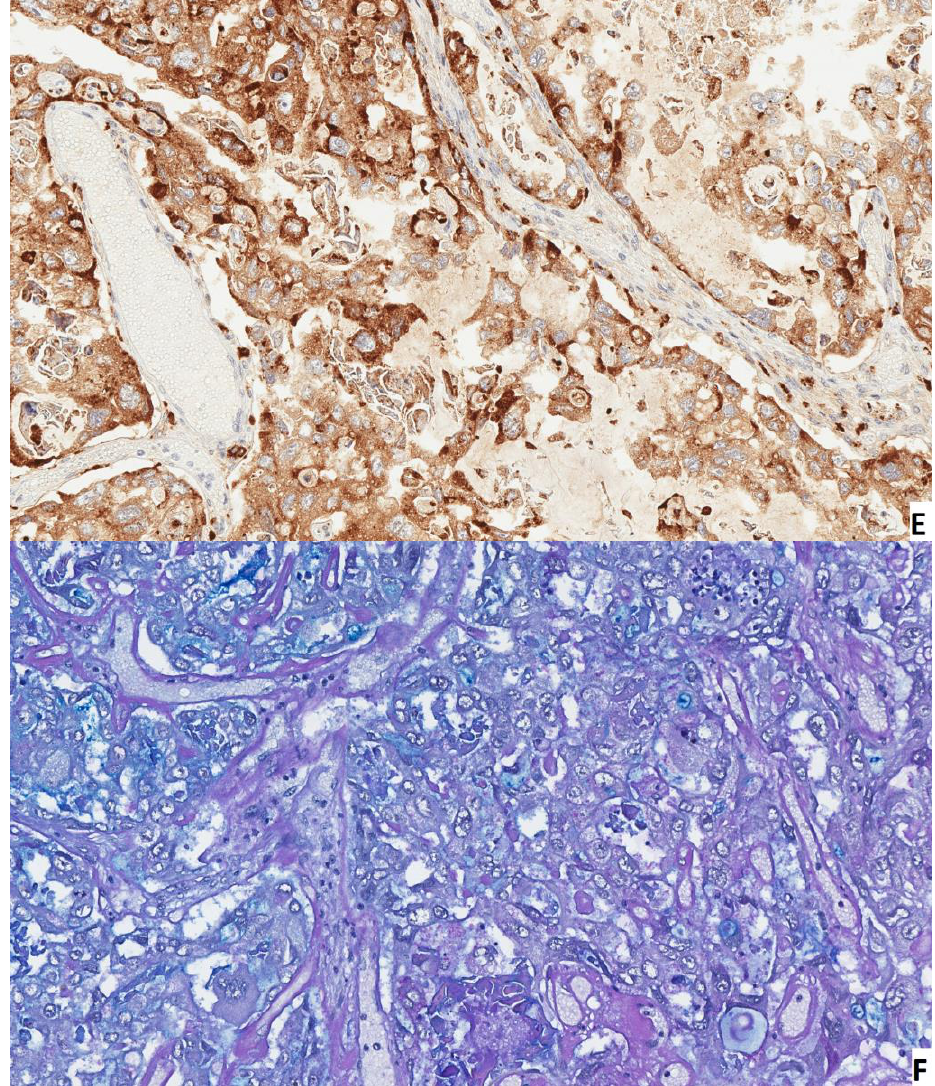
Figure 3. Histopathology of clear cell carcinoma. H&E staining ( A ) shows variation between cells with clear and light eosinophilic cytoplasm. Immunohistochemistry immunoprofile is Wilms tumor 1 (WT-1) negative ( B ), p-53 positive ( C ), HNF1beta negative ( D ), Napsin-A positive ( E ) tumor. Alcian blue/periodic acid–Schiff (AB/PAS) staining ( F ) shows glycogen in clear cells.